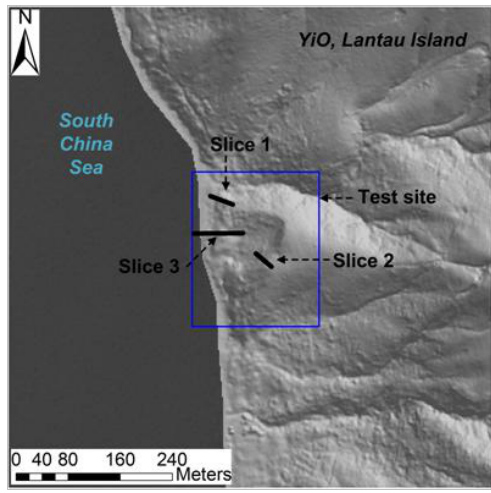
Figure 1. Locations of vertical slices of LiDAR point cloud within the test area The classified LiDAR points in three vertical slices are displayed in Figure 2. The terrain of slices 1 and 3 is gentler than the terrain of slice 2. According to the distribution of LiDAR points in 3D space and the land cover information provided by aerial photo, the slope at the location of slice 1 is regarded to be covered by trees of about three to five meters high. The filtering and classification result in Figure 2a indicates that the PTD filter did not filter out all LiDAR points striking on tree crowns and a part of vegetation points (shown by arrow) were misclassified as ground points. In contrast, the HRI filter filtered out all vegetation points and a large point gap appears on the slope where no laser pulses arrive at the ground (Figure 2b). Figures 2c and 2d indicate a steep slope covered by bushes and trees of about one to three meters high. The